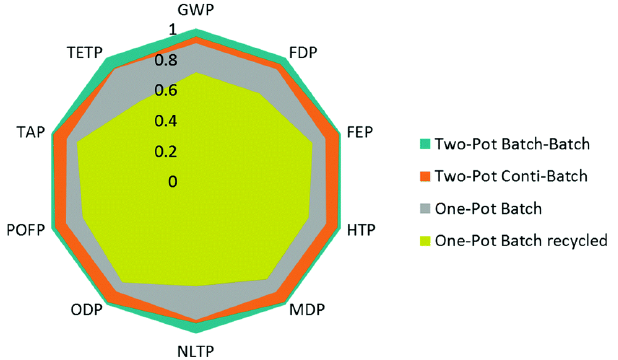
Figure 5. Life Cycle Assessment (LCA) of batch vs. continuous synthesis for rufinamide. Reproduced with permission from Ott et al., Green Chemistry; published by Royal Society of Chemistry, 2016 [56].